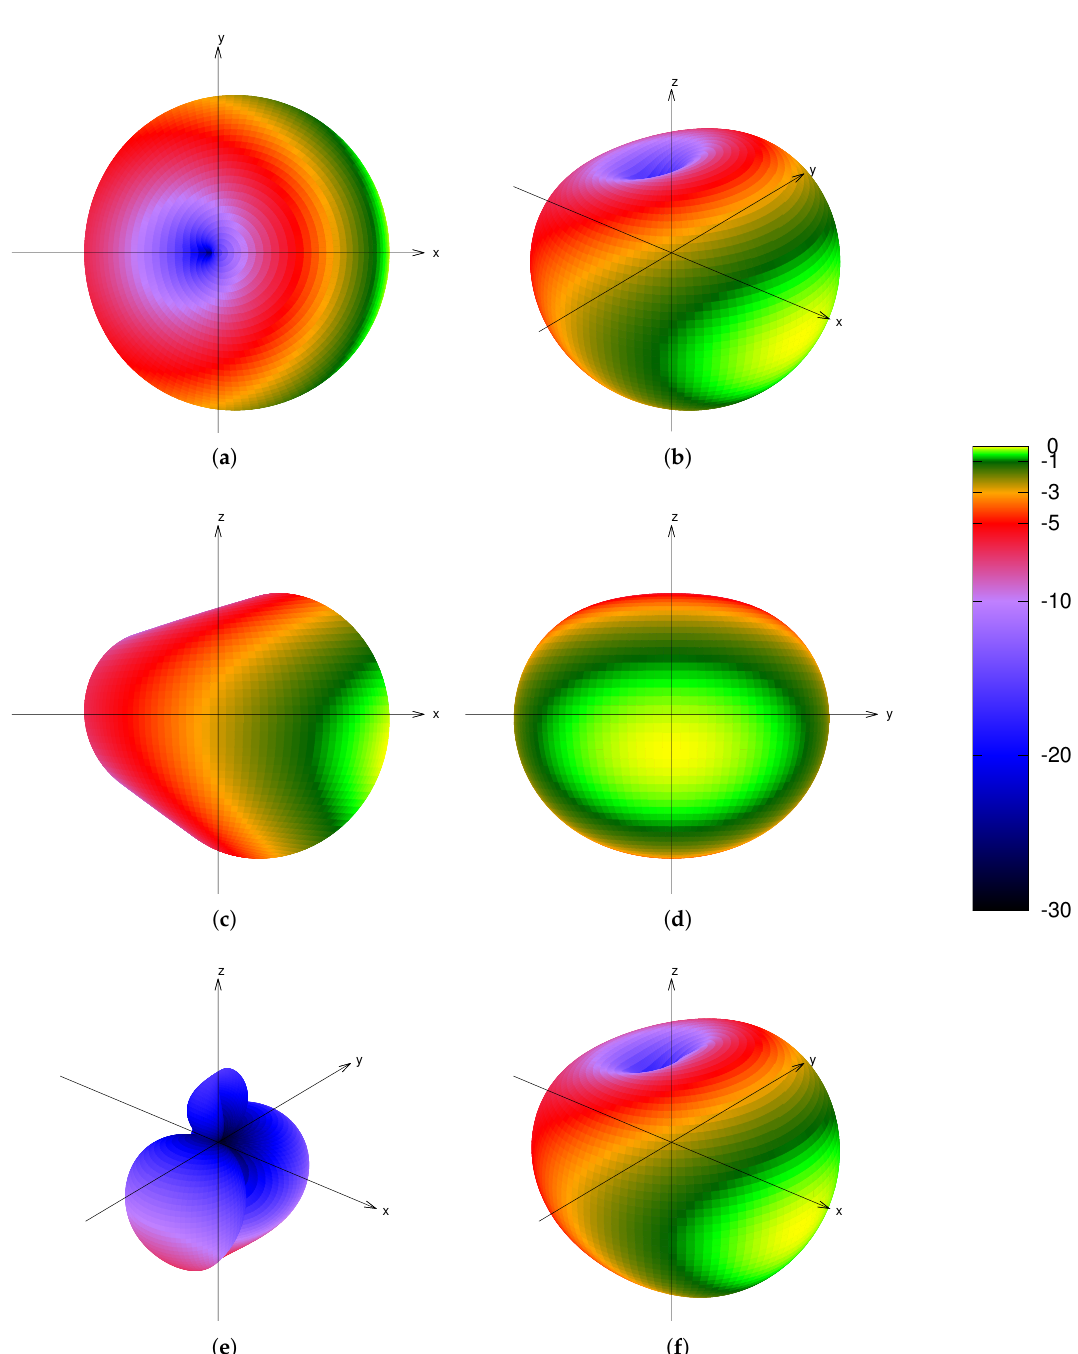
Figure 5. Free-space, far-field 3-dimensional simulated pattern (dB) for the Redhead Point design. It is of note that this and more so the SEAL Figure 6d antenna direct their energy down towards the sea surface. ( a ) shows the plan view while ( c , d ) show the side and front elevations of the pattern. The remaining oblique views, ( b , e , f ) show the radiation patterns for the combined, horizontal and vertical polarisations respectively. The images show relative directional antenna gain and are mapped with the ( − 30 dB,0 dB ) (cid:55)→ r = ( 0,1 ) radius of the unit sphere. Gain is normalized such that 0 dB (cid:55)→ − 18.04